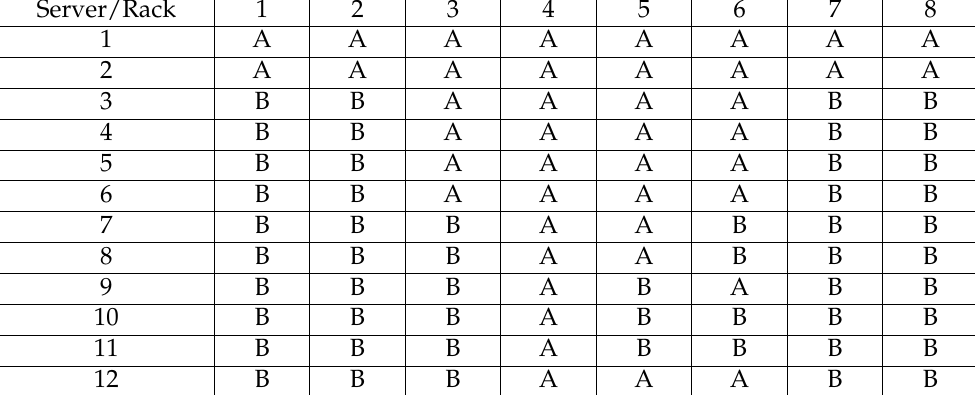
Table 4. Updated placement of servers after applying HASRA.